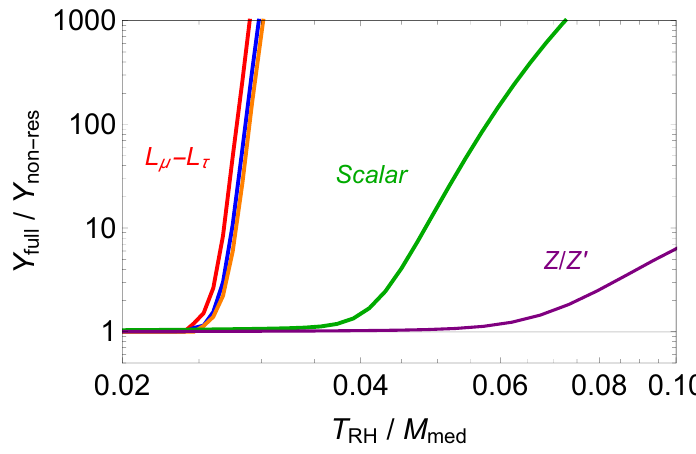
Figure 7 . Ratio of the dark matter relic abundance from the full calculation to that obtained in the non-resonant EFT approximation, as a function of T RH /M med . From left to right, the curves are for the L µ − L τ model with M med = m Z 0 = 0 . 1 , 1 , 10 TeV (red, blue, orange curves respectively), the scalar model (green curve, with M med = m h ) and Z 0 kinetic mixing model (purple curve, with M med = m Z ). For all curves, the couplings are chosen such that the full calculation gives the correct relic abundance for m X = 1